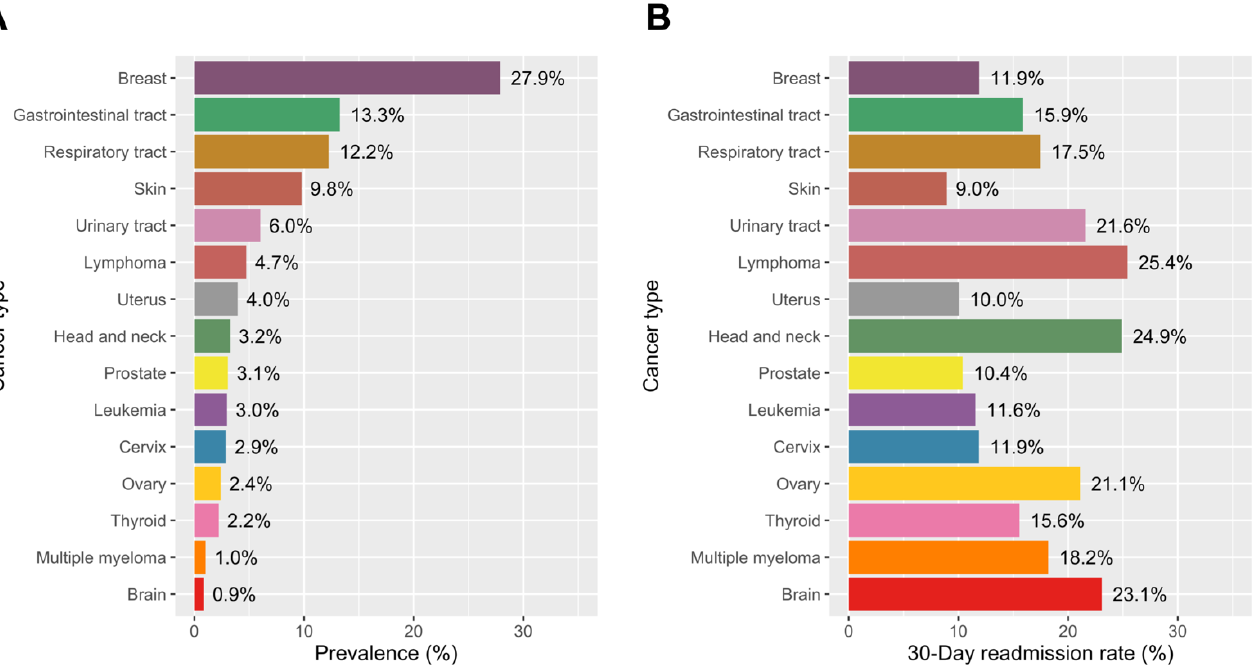
Figure 3. Thirty-day Readmission Rates of Takotsubo Syndrome by Cancer Types. ( A ) Prevalence of each type of cancer in TTS patients with malignancy. ( B ) 30-day readmission rates according to the cancer type in TTS patients with malignancy. Abbreviations: TTS, Takotsubo syndrome.